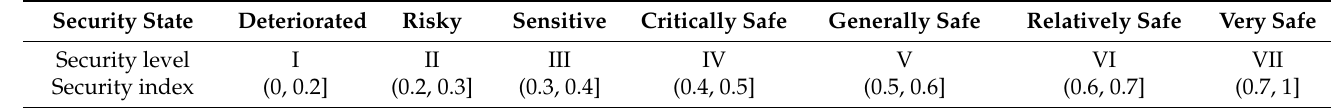
Table 2. Grading criteria for the comprehensive tourism eco-security assessment of the Yellow River